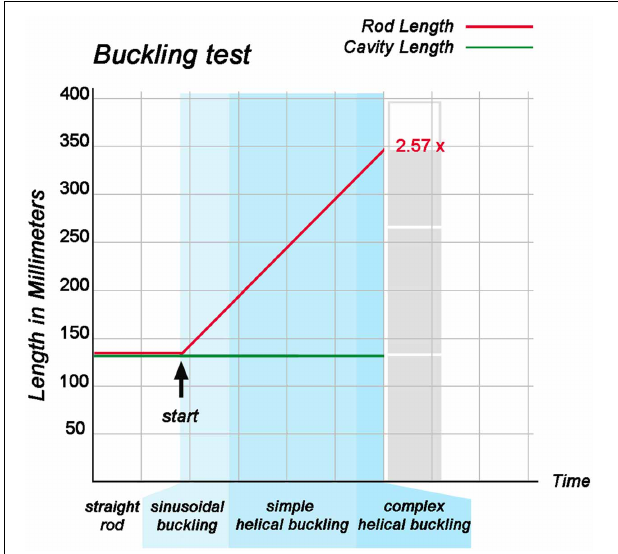
FIGURE 7 | This graph illustrates the relation between the rate of elongation of the “intra-pericardial” portion of the silicone rod and its form changes during the first buckling experiment. During the whole experiment, the “cranio-caudal” length of the “pericardial” cavity remained constant, while the “intra-pericardial” portion of the silicone rod underwent considerable elongation. At the start of the buckling test, the “intra-pericardial” portion of the silicone rod was straight and had the same length as the “pericardial” cavity (136mm; length-to-diameter ratio for the rod = 5.9). Lengthening of the “intra-pericardial” portion of the rod led to sinusoidal buckling. The switch from sinusoidal to simple helical buckling occurred at 183mm length (length-to-diameter ratio = 7.96), while the switch from simple to complex helical buckling occurred at 327mm length (length-to-diameter ratio = 14.22). At the end of the buckling test, the length of the “intra-pericardial” portion of the rod was 350mm (length-to-diameter ratio = 15.22), which is 2.57 times longer than the “pericardial” cavity.